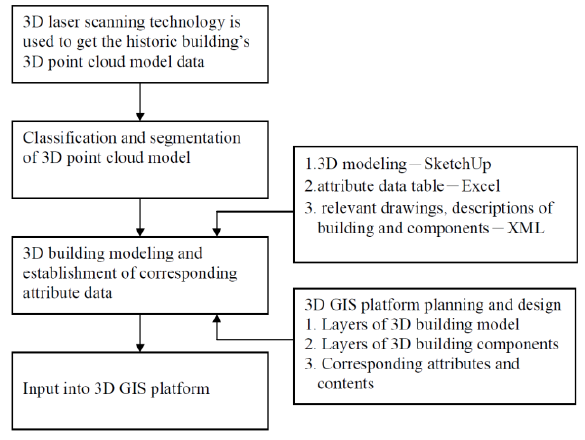
Figure 1. Research procedure